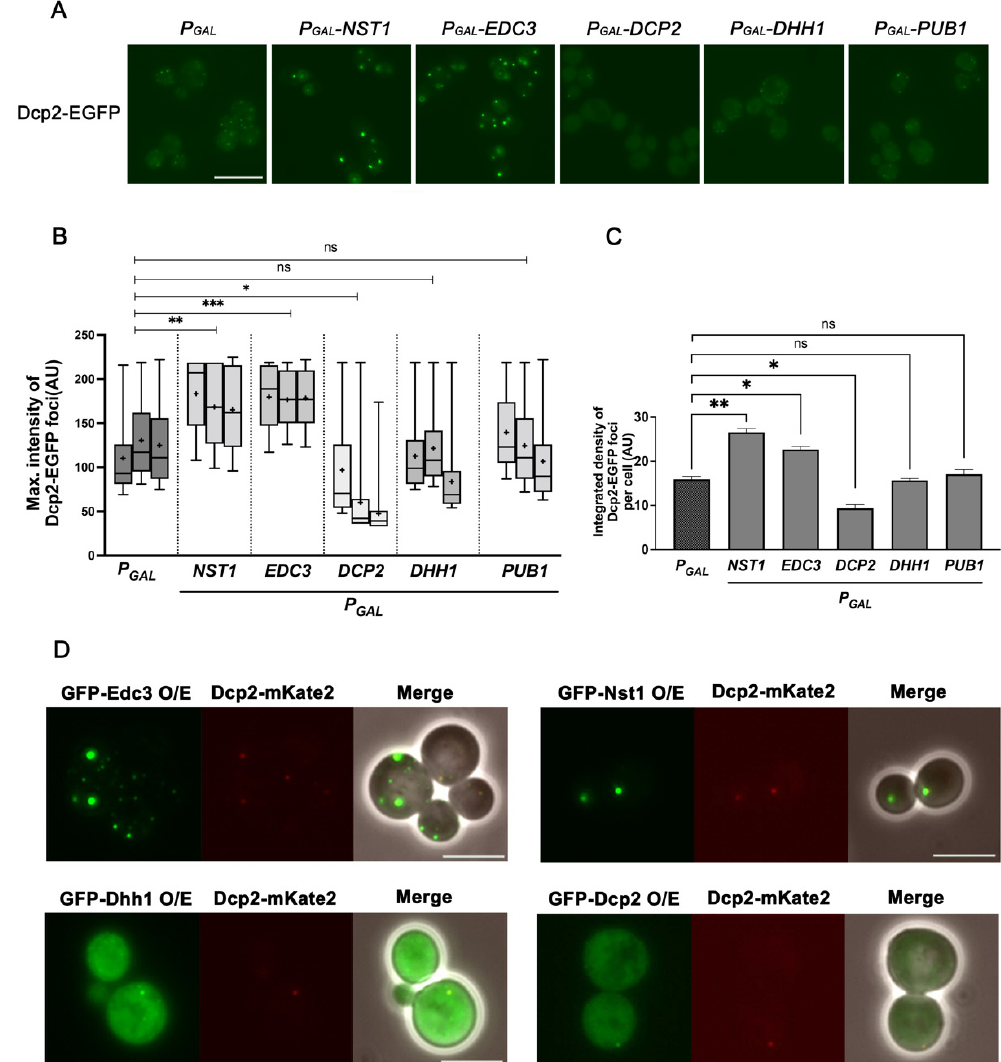
Figure 4. Nst1 overexpression induces Dcp2 accumulation by self-condensation similar to Edc3, while overexpression of Dcp2, Dhh1, and Pub1 does not. ( A – C ) Dcp2 accumulation in the cells respectively overexpressing Nst1, PB components Edc3, Dcp2, and Dhh1, and a SG component Pub1. The wild-type cells, whose chromosomal DCP2 was tagged with EGFP (YSK3485), were transformed with pMW20-pGAL (vector control), pMW20-pGAL-NST1, pMW20-pGAL-EDC3, pMW20-pGAL-DCP2, pMW20-pGAL-DHH1, and pMW20-pGAL-PUB1 . Cells cultured in a SD-U (2% glucose) medium were transferred to a 2% raffinose + 0.1% glucose medium for 3 h, and galactose was added to a final 2% concentration to induce the expression for 3.5 h. ( A ) Fluorescence microscopy of the endogenous Dcp2-EGFP in cells respectively overexpressing Nst1, Edc3, Dcp2, Dhh1, and Pub1. Scale bar, 10 μ m. ( B , C ) Measurements of Dcp2-EGFP puncta induced by the overexpression of Nst1, Edc3, Dcp2, Dhh1, and Pub1 of ( A ). Approximately, 200 cells of each strain were monitored for one independent analysis, and every experiment was repeated three times. Pixels of top 0.05% Dcp2- EGFP signal intensity were segmented for the analysis. The segmentation and quantification meth- ods applied to the images are described in the Section 4. ( B ) Monitoring maximum signal intensities of Dcp2-EGFP puncta by overexpression of Nst1, Edc3, Dcp2, Dhh1, and Pub1. The maximal inten- sity of segmented puncta was plotted on the y -axis and presented using a boxplot. The error bar shows mean values ± standard error of the mean (SEM). Statistical significance was determined using a nested t test (* p < 0.05, ** p < 0.01, *** p < 0.001). ( C ) Quantitative analysis of Dcp2-EGFP